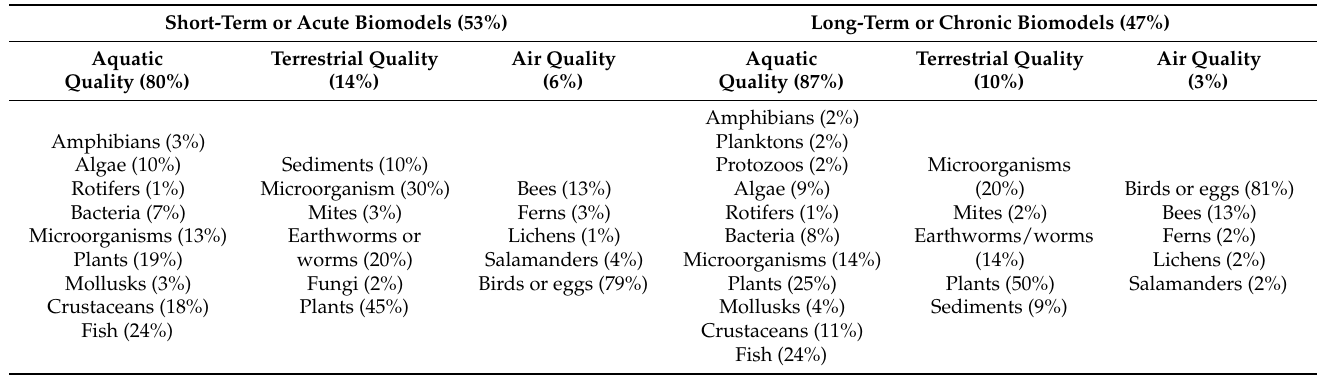
Table 2. Ecotoxicologial studies found in the literature (WOS on 9 September